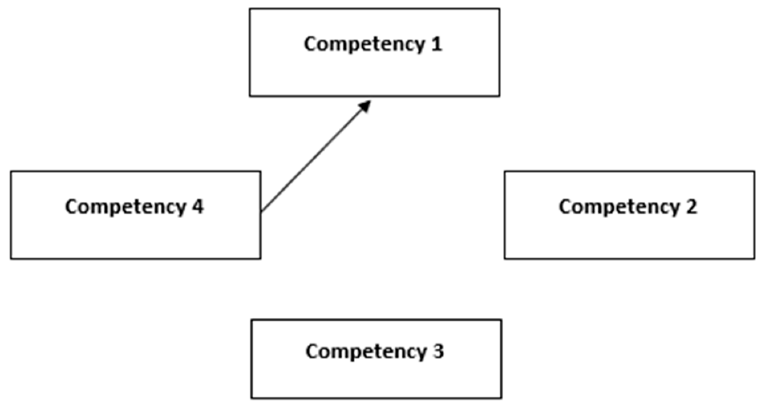
Figure 3. Impact-relation map for the competencies.